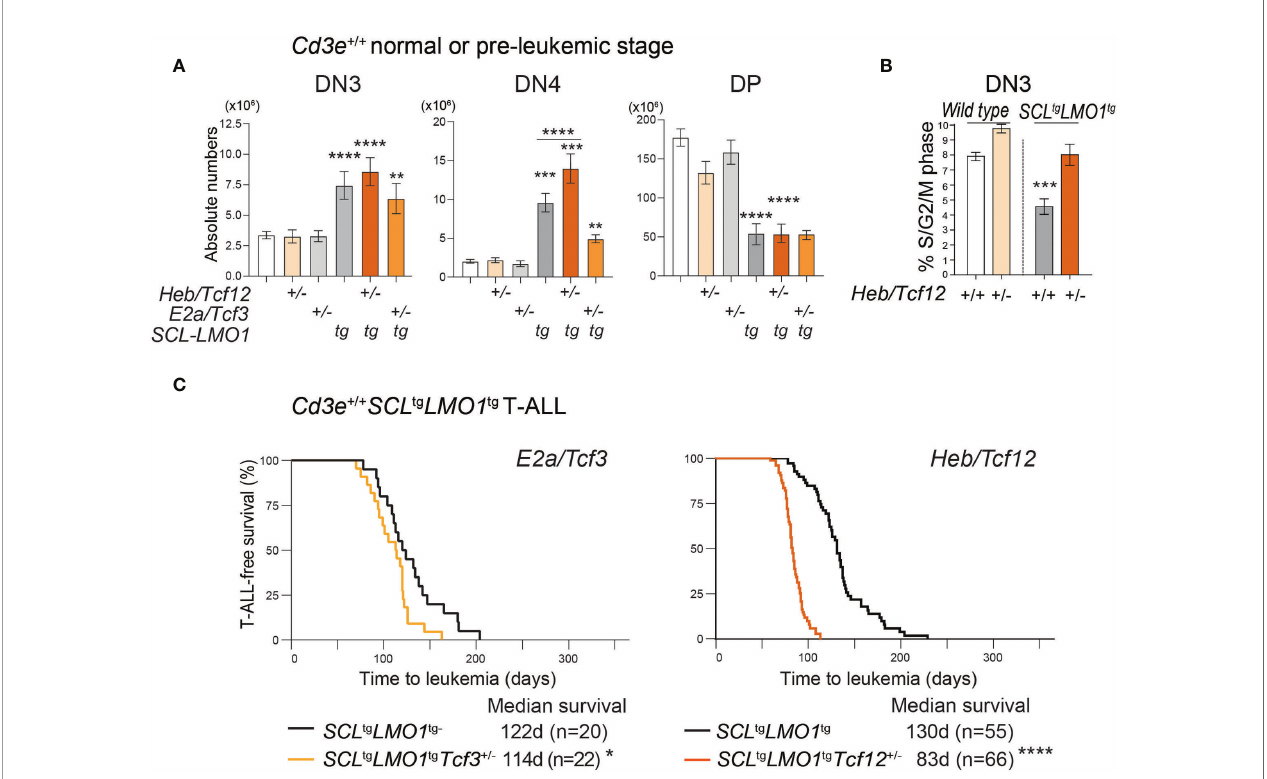
FIGURE 3 | HEB restricts cell proliferation at the b ‐ selection checkpoint and acts as a tumor suppressor in T-ALL. (A) Effect of loss of one allele of Heb / Tcf12 or E2a / Tcf3 on the absolute numbers of thymocytes within the indicated subsets in a wt or SCL tg LMO1 tg background. Shown are the average ± SD of at least 9 mice per group (5-6 weeks). Where not speci fi ed P value is compared to wild type control: **p = 0.0039, ***p < 0.002 and ****p < 0.0001. (B) Monoallelic Heb/Tcf12 deletion increased S/G2/M phase in Cd3e-de fi cientpre-leukemic DN3 thymocytes. Cell cycle analysis of Cd3e-de fi cient thymocytes in Heb/ Tcf12+/+ andHeb/Tcf12+/- backgrounds. *p value <0.01). (C) Kaplan-Meyer survival curves comparing E2a/Tcf3 +/+ with E2a/Tcf3 +/- backgrounds (left panel) as well as Heb/Tcf12 +/+ and Heb/ Tcf12 +/- backgrounds in Cd3 e -pro fi cient SCL tg LMO1 tg leukemias. In both panels, the +/+ genotypes are wild type littermates of +/- mice. N represents the numbers of mice and the median survival in days was computed from the survival curves. *p = 0.039 and ****p <